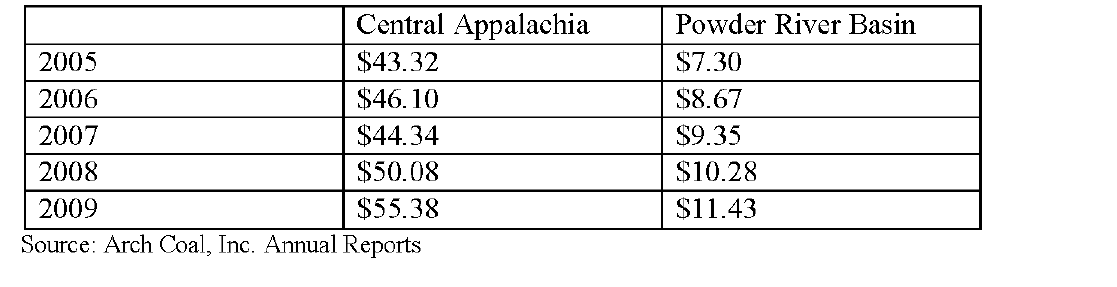
Fignre 4. Operating Costs for Arch Coal